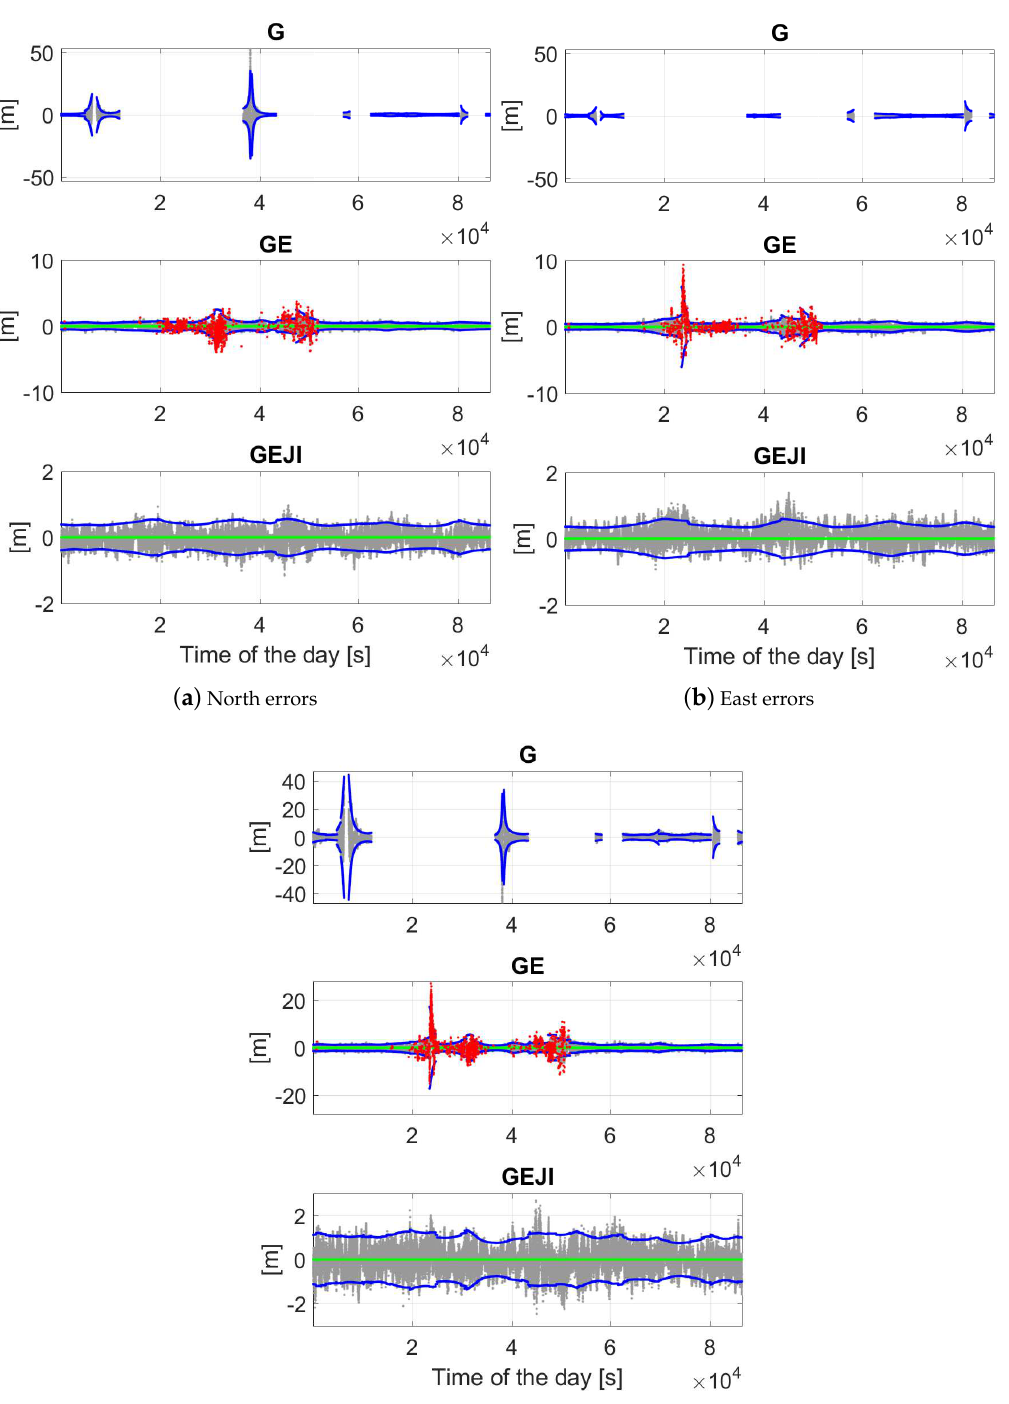
Figure 11. Baseline errors in the north ( a ); east ( b ); and height ( c ) directions with the elevation mask of 10 degrees. Data for baseline CUAA-CUCC on DOY 224, 2018 was used. The gray and blue dots are the ambiguity-float solutions and their 95% formal confidence intervals, respectively. For combined solutions, the green and red dots illustrate the ambiguity-correctly-fixed and -wrongly-fixed solutions, respectively. Note that the scales of the sub-figures are